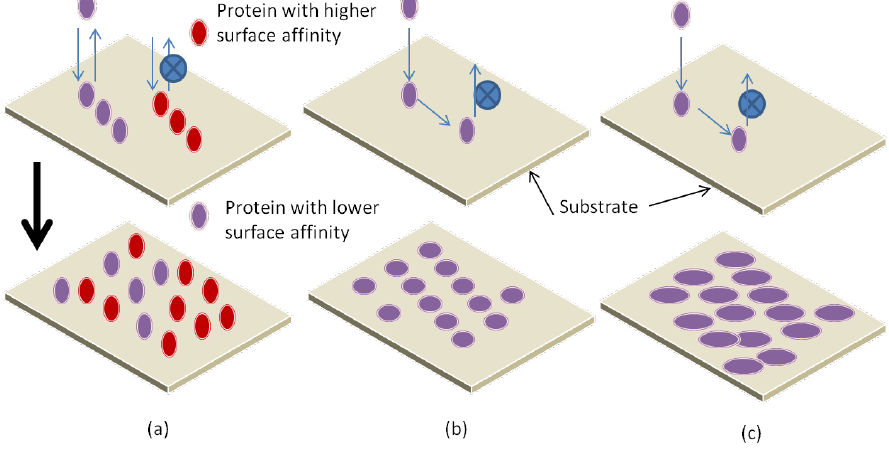
Figure 13. Adsorption Kinetics of proteins with surface. ( a ) Proteins with higher surface affinity replace the proteins with lower surface affinity; ( b ) Change of the protein's orientation after adsorption on surface; ( c ) Proteins with end-on orientation allows more species to adsorb on the